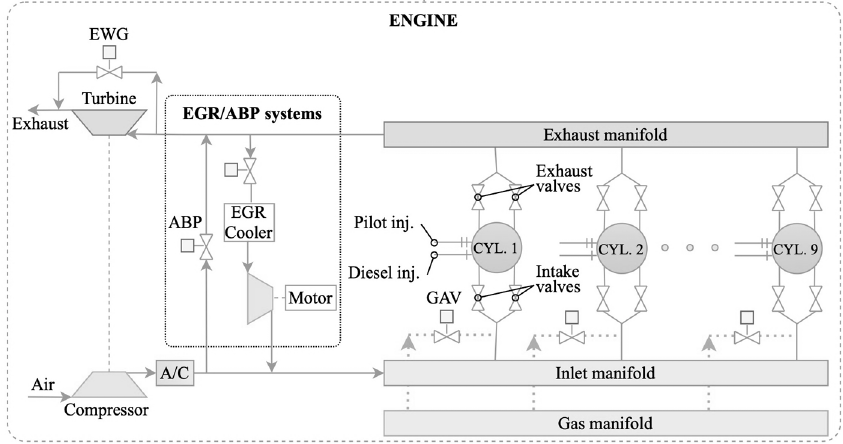
Figure 1. Engine layout with exhaust gas recirculation (EGR) and air bypass (ABP) systems.